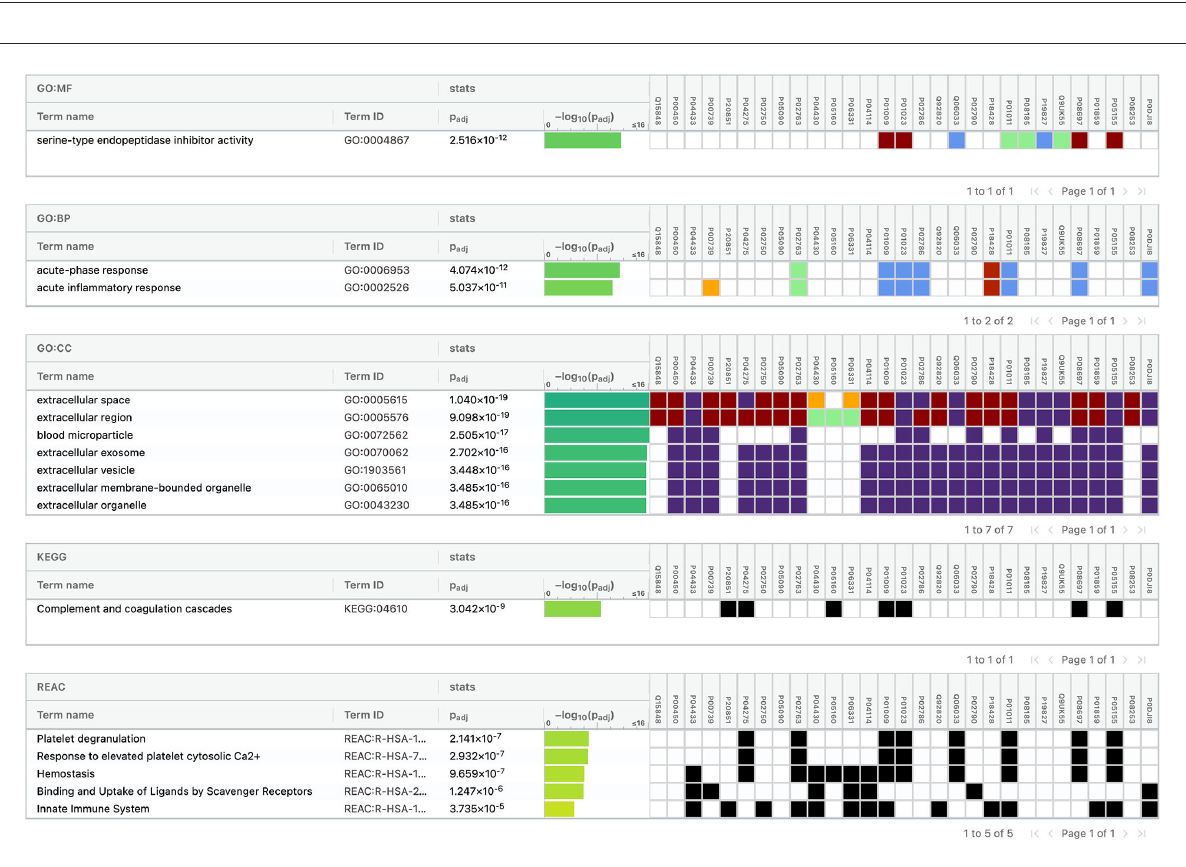
FIGURE4 Functional enrichment analysis of differentially expressed proteins between total stroke and healthy